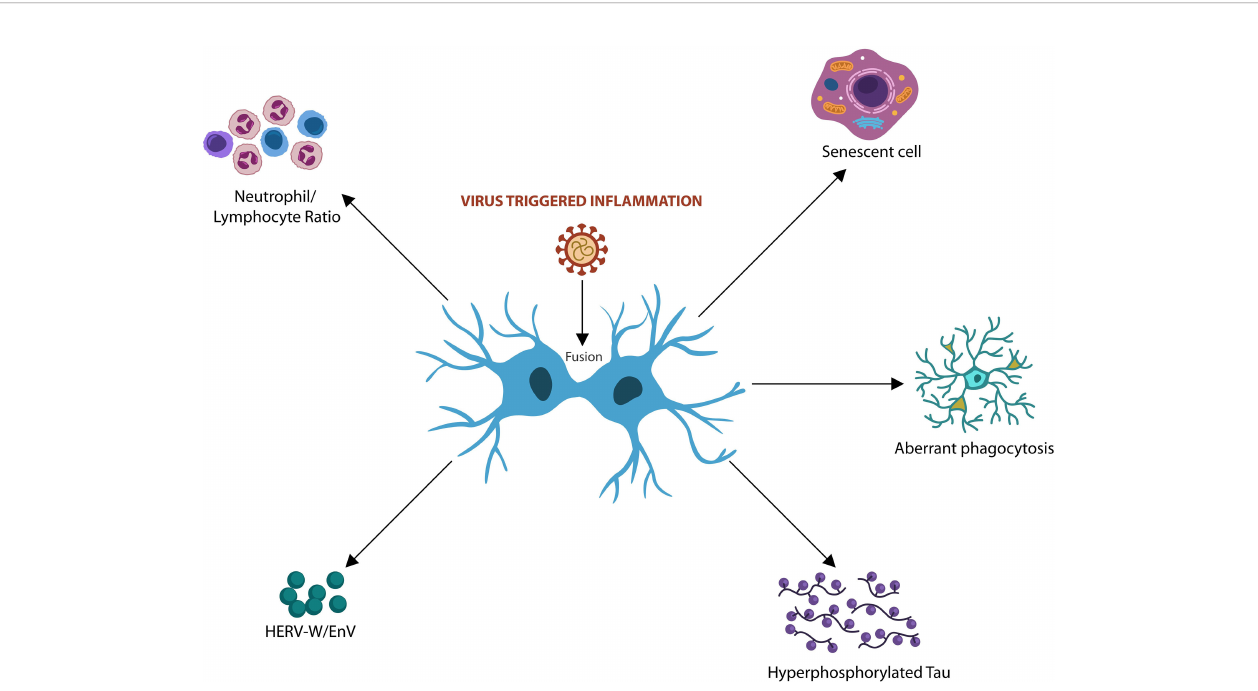
FIGURE 2 | Virus-induced fusion and syncytia formation trigger host cellular senescence and immunosuppression associated with tauopathies. Elevated neutrophil/ lymphocyte ratio (NLR) and premature senescence were associated with both viral infections and AD. Virus-activated HERVs and Tau hyperphosphorylation were linked to neurodegeneration. Cell-cell fusion drives aberrant microglia and neurotoxic astrocytes that often engulf viable neurons and synapses, contributing to